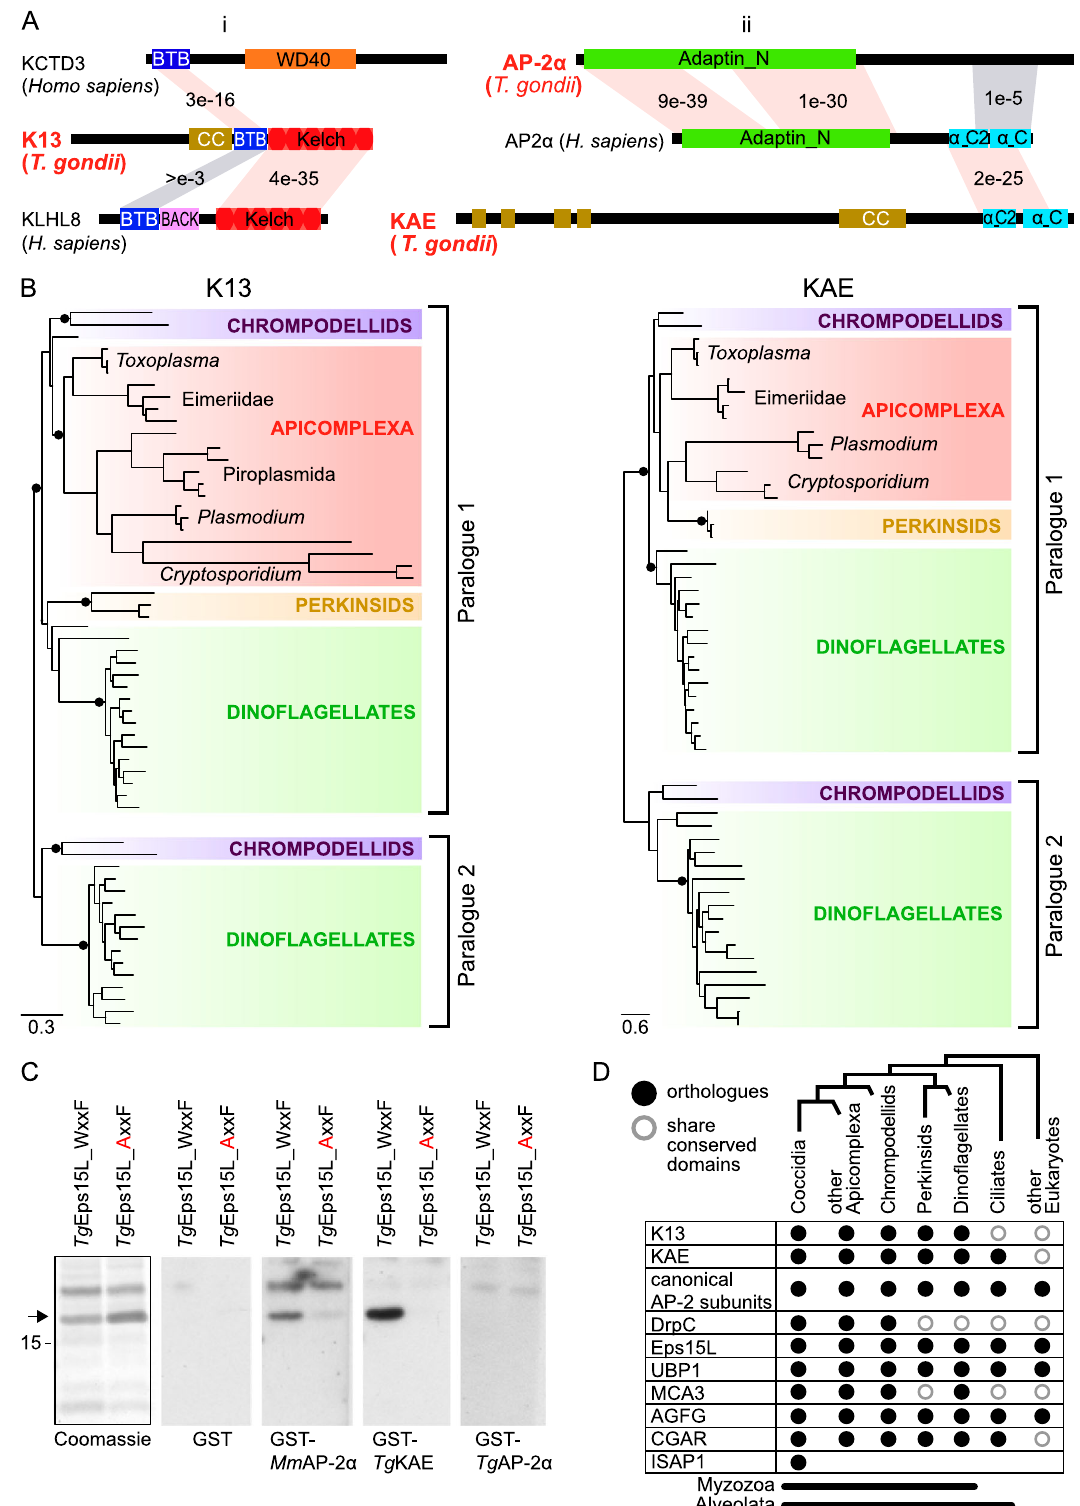
Fig. 7 | K13 and AP-2 unique traits co-evolved in Myzozoa. A Domain archi- tectures of: (i) K13 compared to proteins from humans, which demonstrate high sequencesimilaritytotheBTBandKelchdomains,and(ii)apicomplexanAP-2 α and KAE compared to human AP-2 α as canonical representative. BLASTP E -values indicate relative conservation between common domains. Conserved domains shown in colour; CC, coiled coil. B Maximum-likelihood phylogenies for K13 and KAE. SH-like aLRT branch supports over 0.9 are indicated by black dots, and completephylogeniesareshowninFig.S11D. C Far-Westernblotswithimmobilized